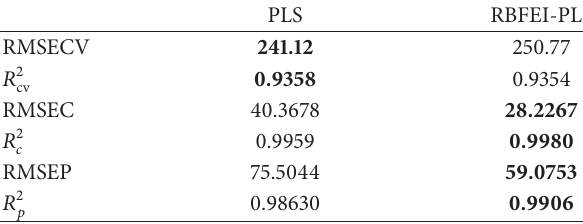
Table 3: Experiment results for CO